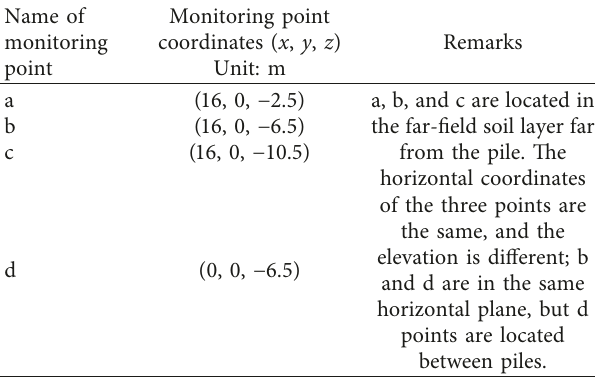
Figure 8: Dynamic calculation model.